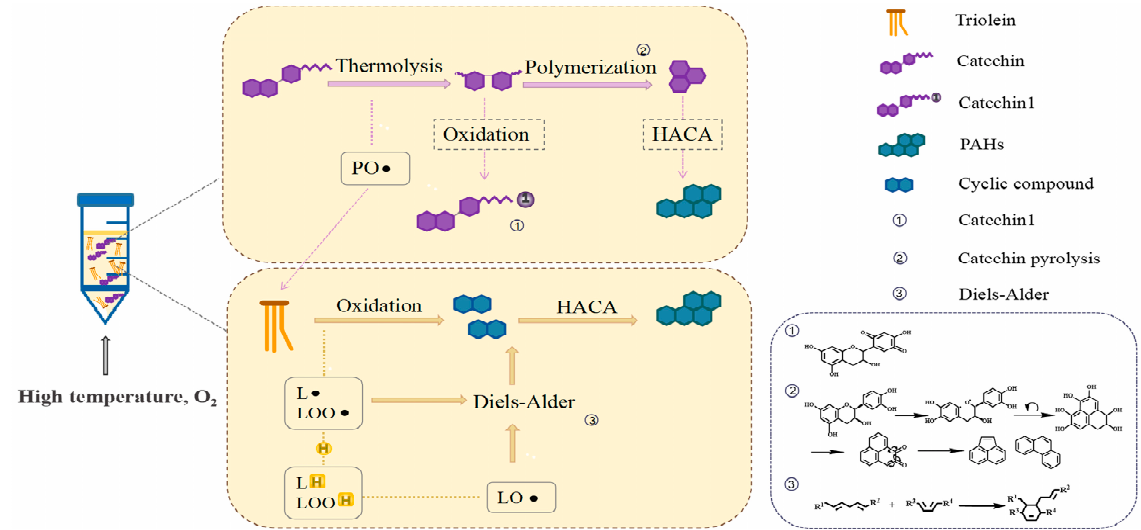
Figure 7. Speculative path of PAH4 formation in C. oleifera oil.